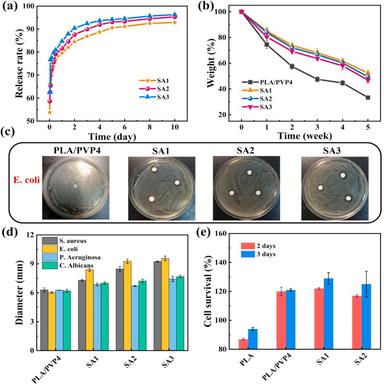
Antibacterial performance and degradation of PLA/PVP drug-loaded nanofiber membranes: (a) Sustained release, (b) Degradability, (c) Antibacterial effect diagram, (d) Antibacterial activity and (e) Cytotoxicity.